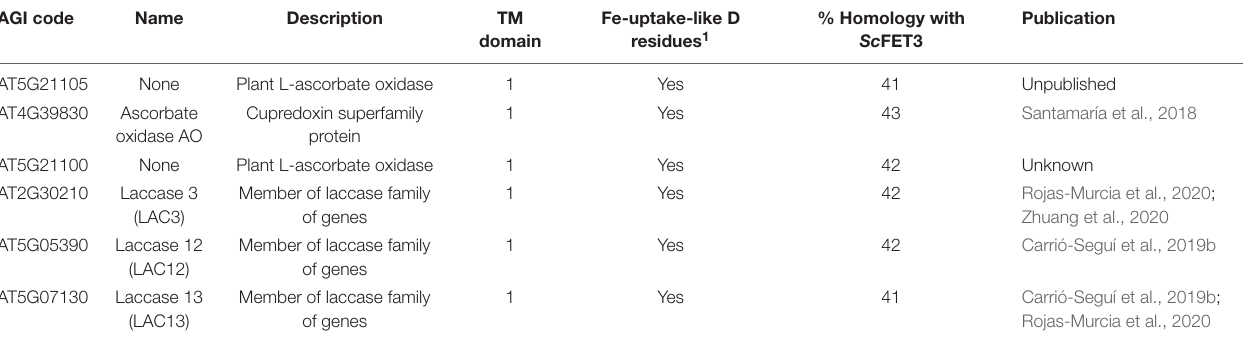
TABLE 2 | Putative candidate genes for ferroxidase functions identified through in silico analysis. AGI